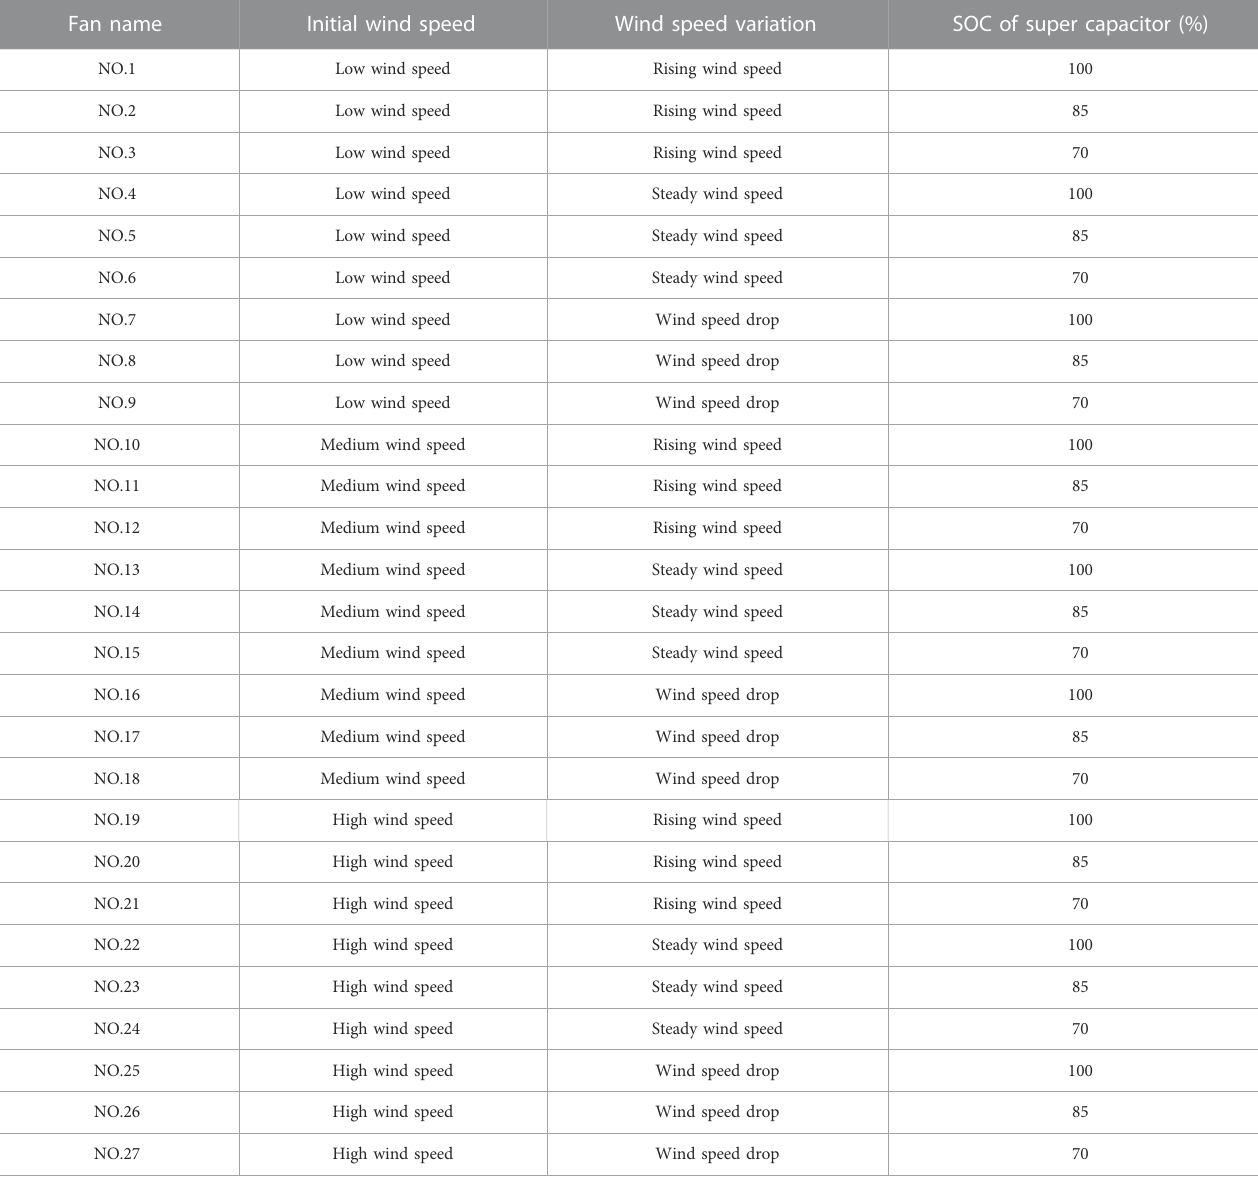
TABLE A1 27 units with rated power of 2.5 MW the states and working conditions of different DFIG.